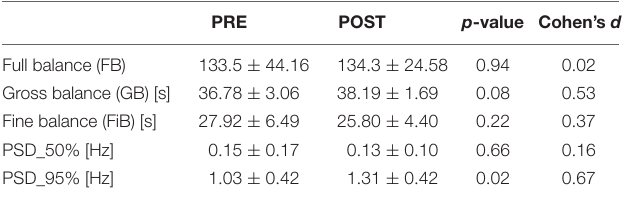
TABLE 1 | Kinematics and power spectral density results before and after the fatigue